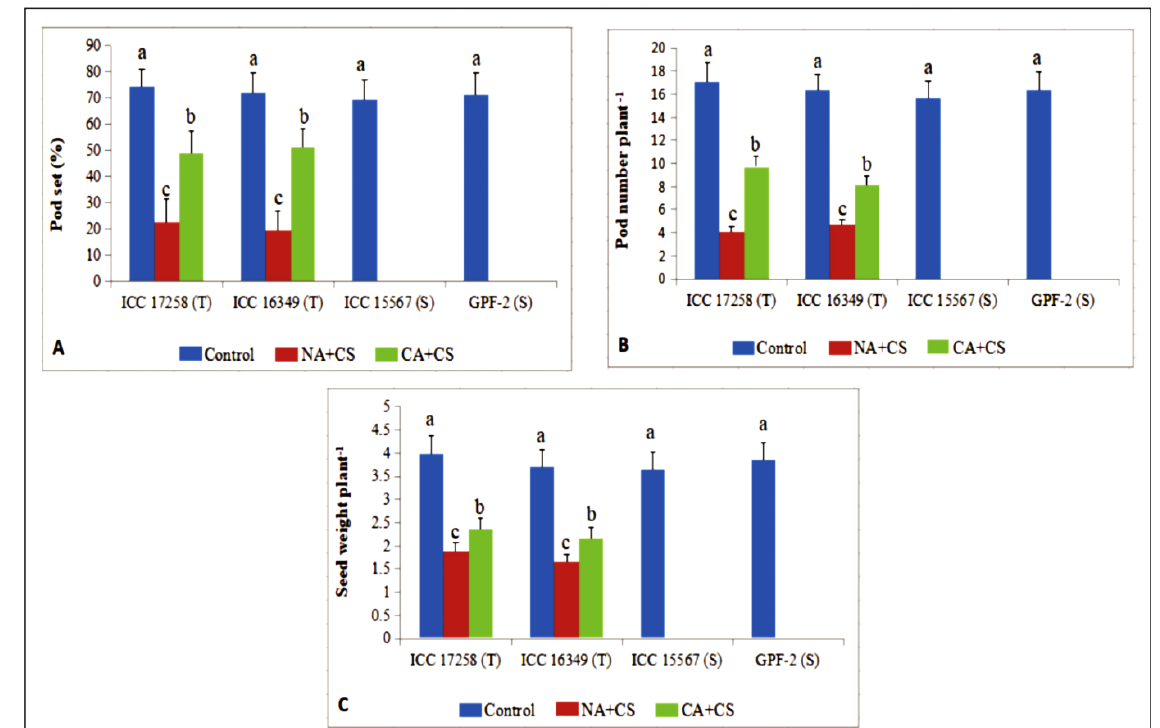
Figure 10. Pod set ( A ), pod number plant −1 ( B ) and seed weight plant −1 ( C ) in plants of control, non-acclimated, cold stressed; NA + CS) and cold-acclimated, cold stressed (CA + CS) plants of tolerant (T) and sensitive (S) genotypes. Small vertical bars represent standard errors (Mean ± S.E; n = 3). Different small letters on vertical bars indicate significant differences from each other ( p < 0.05; Tukey’s test). Least significant difference (LSD) for interaction ( p < 0.05) (Genotypes × treatments): Pod set (10.3), Pod number (1.8), Seed weight (0.41).